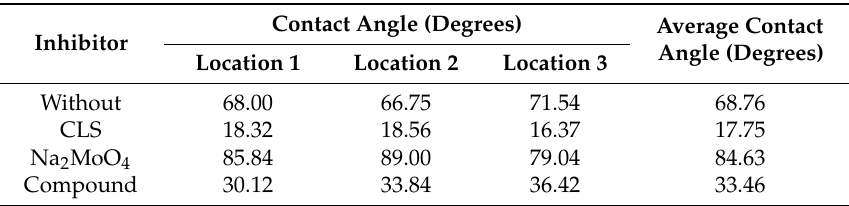
Figure 12. Typical images of water droplets on different inhibitor treated Q235 steel surfaces. Table 2. Electrochemical parameters of Q235 steel in carbonated SCP solution with different ratios of CLS and Na 2 MoO 4 using CPP measurements.